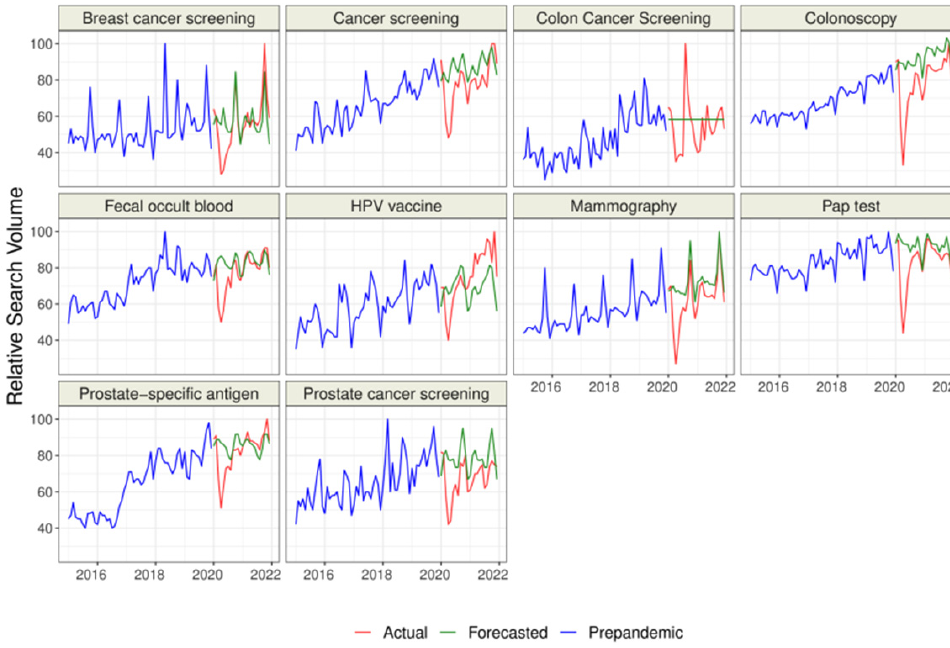
Figure 1. Relative Search Volume of Google queries on chosen cancer-related screenings.